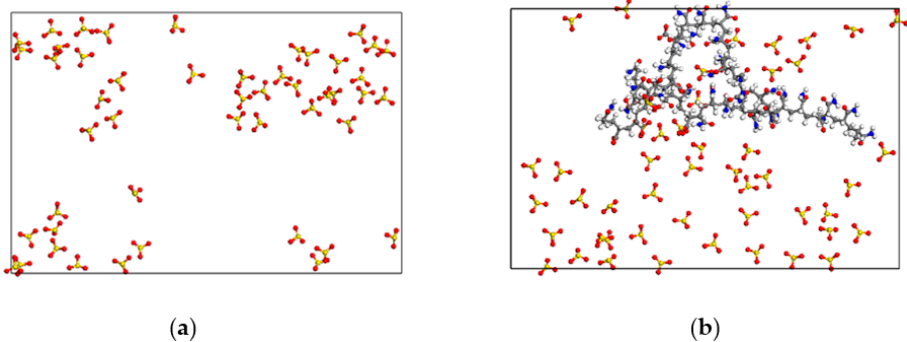
Figure 7. Snapshots of the molecular configuration of adsorption layer after dynamics relaxation equilibrium. ( a ) “SDBS” system; ( b ) “SDBS/HPAM” system.